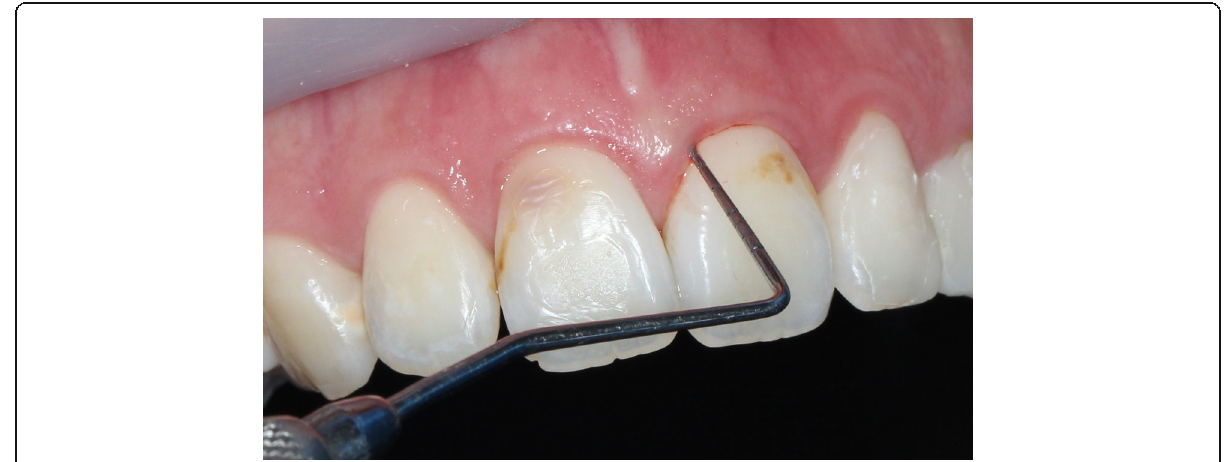
Fig. 1 Peri-implant bleeding on